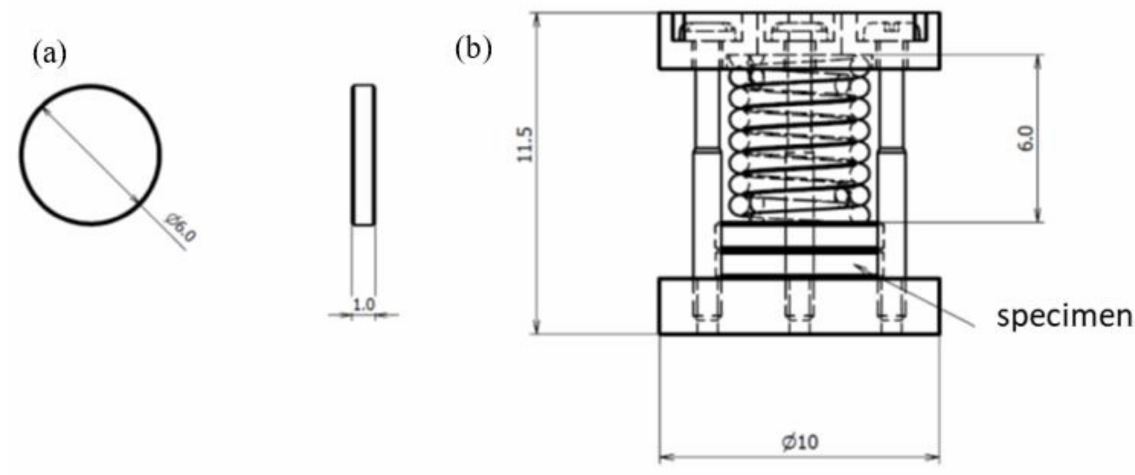
Figure 5. Crevice specimen geometry and dimension and contact pressure control jigs.